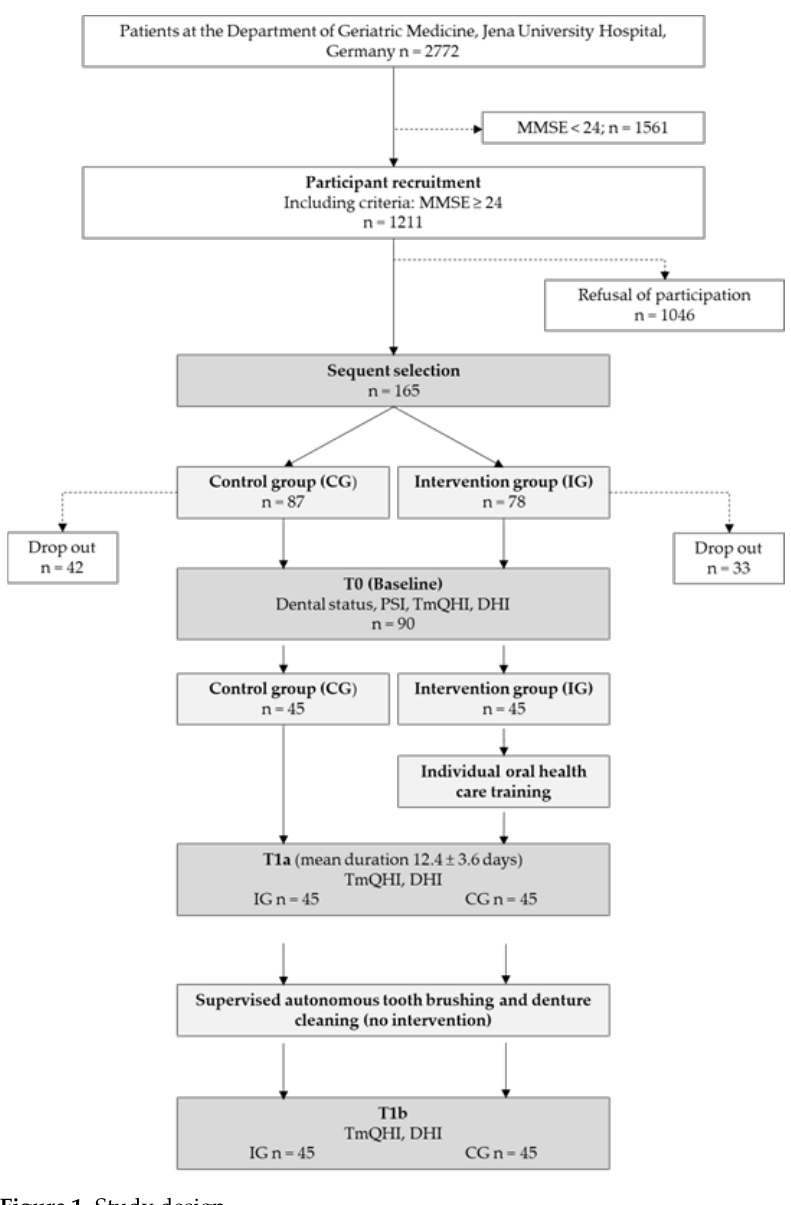
Figure 1. Study design.